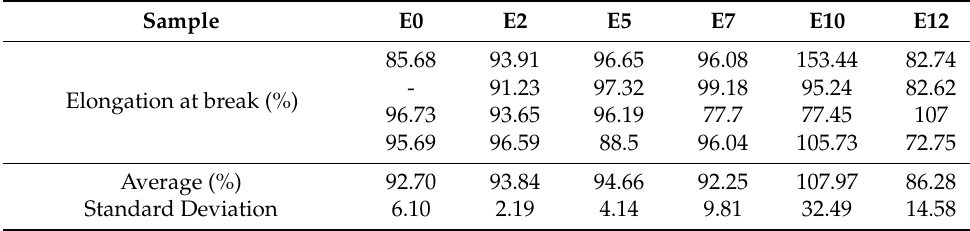
Table 3. Average elongation at break of the samples (%).